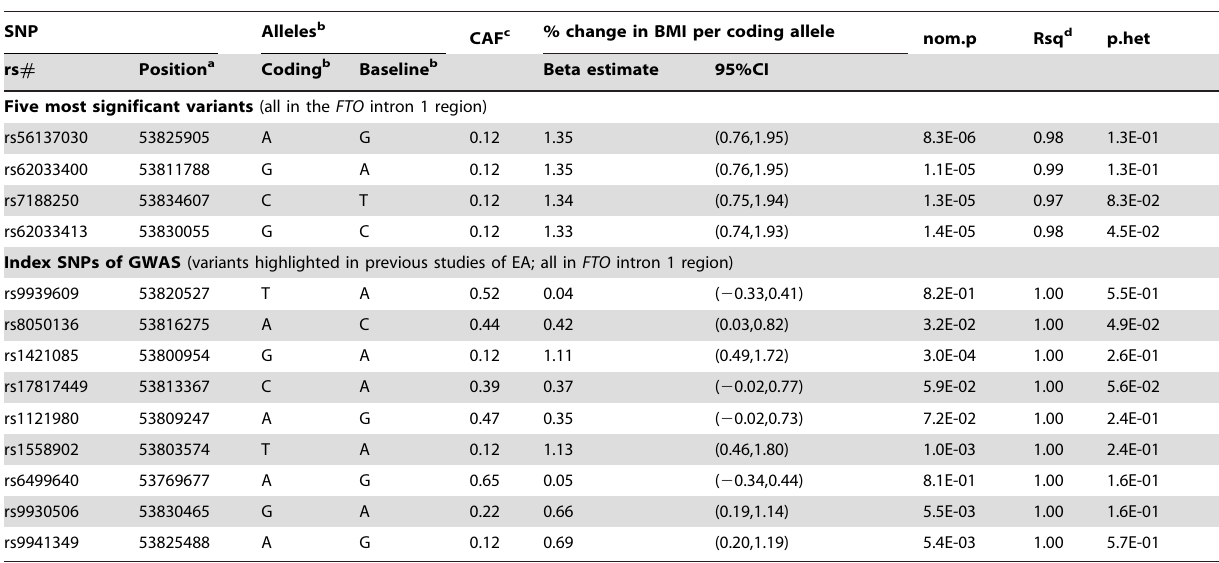
Table 3. Association between SNPs in the FTO region and BMI for all studies combined.